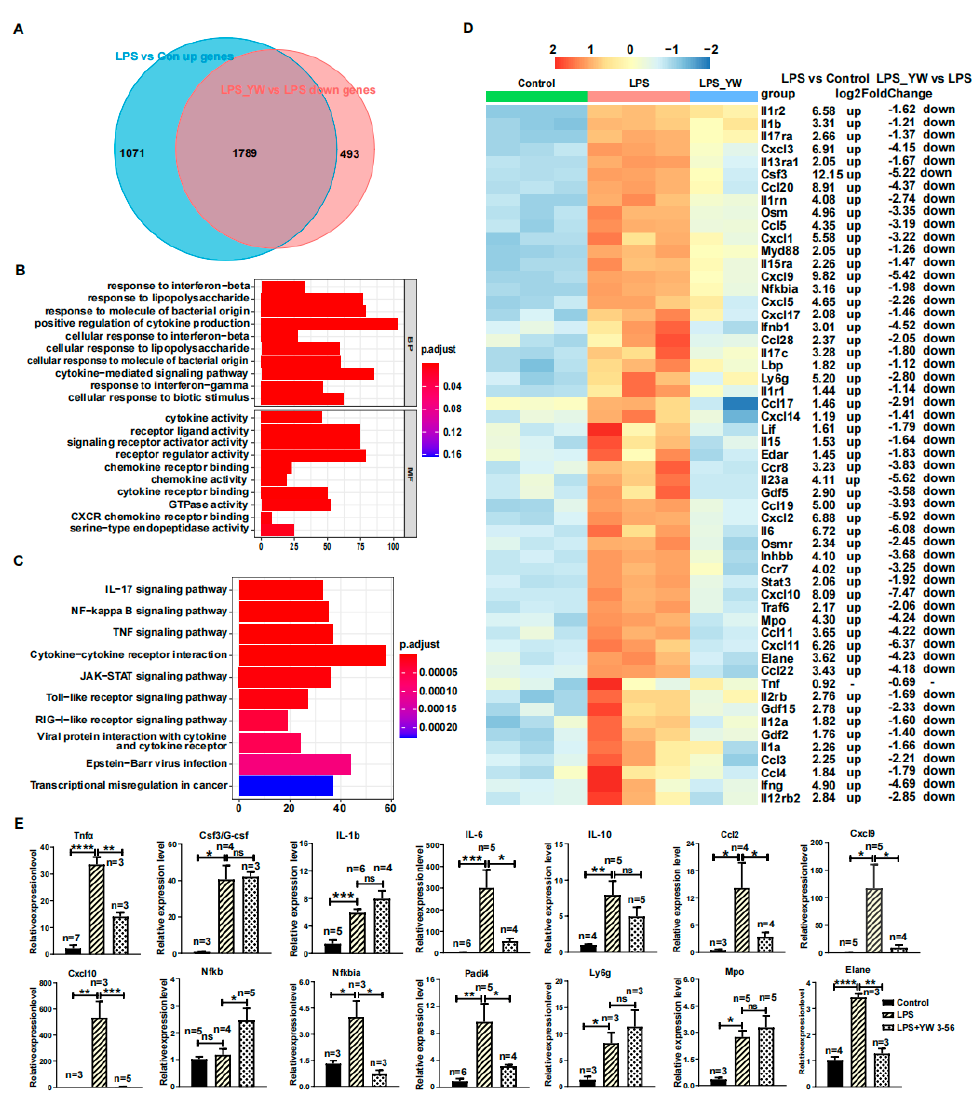
Figure 6. YW3-56 reversed LPS-induced upregulation of inflammation-related genes. ( A ) There were 1789 genes in the intersection of upregulated genes in LPS relative to control samples and downregulated genes of LPS and YW3-56 dual treatment relative to LPS treatment